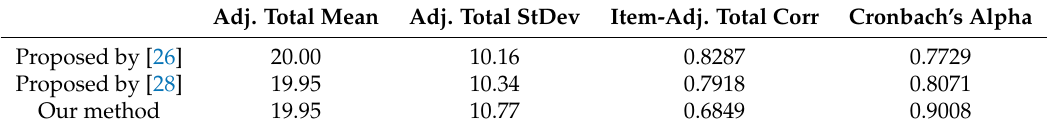
Table 11. Correlation between our method’s final ranking and other MCDM